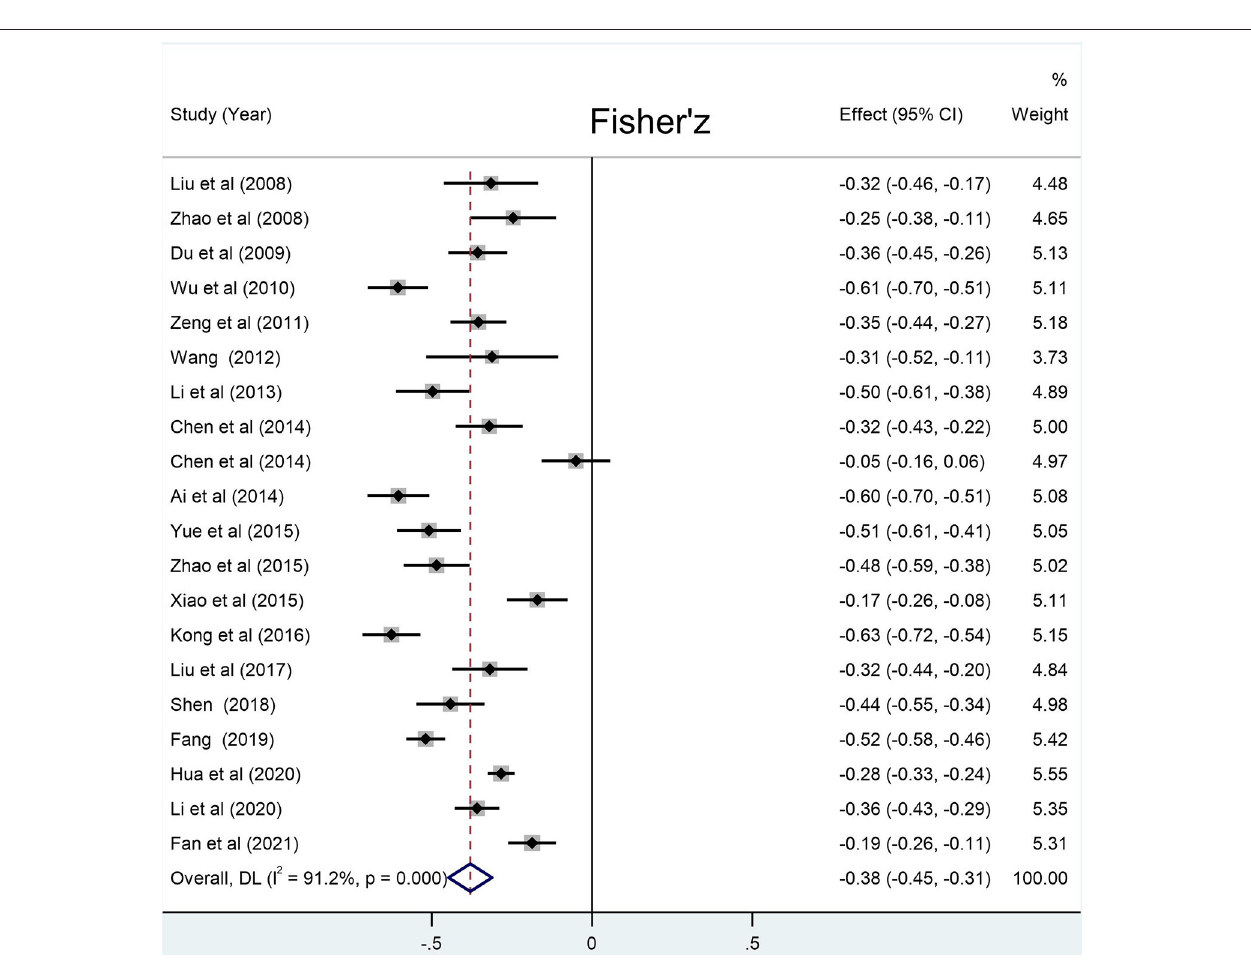
FIGURE 2 | Forest plots for the correlation between social support and loneliness. Weights are from random-effects